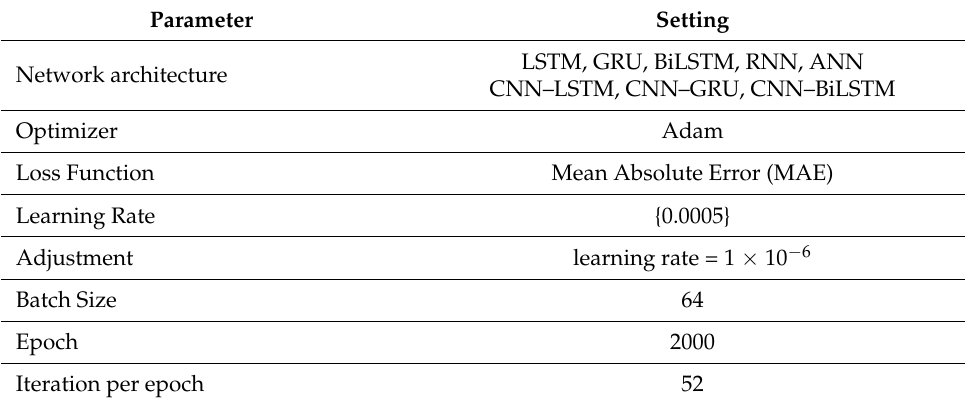
Table 1. Hyperparameters of the proposed hybrid DL model.